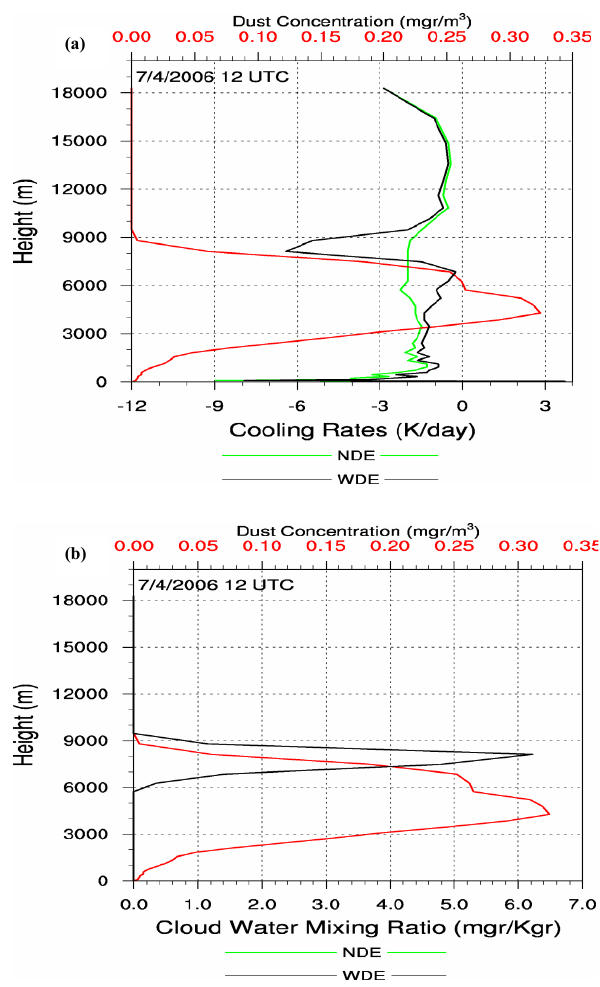
Fig. 4. Vertical distribution of (a) cooling rates and (b) cloud water mixing ratio (mgr/Kgr) over the solar radiation station in Crete on 7 April 2006 at 12:00UTC for both model setups (black line denotes WDE). For the NDE simulation, cloud water mixing ratio is zero. The vertical distribution of dust concentration in mgrm − 3 is also shown (red